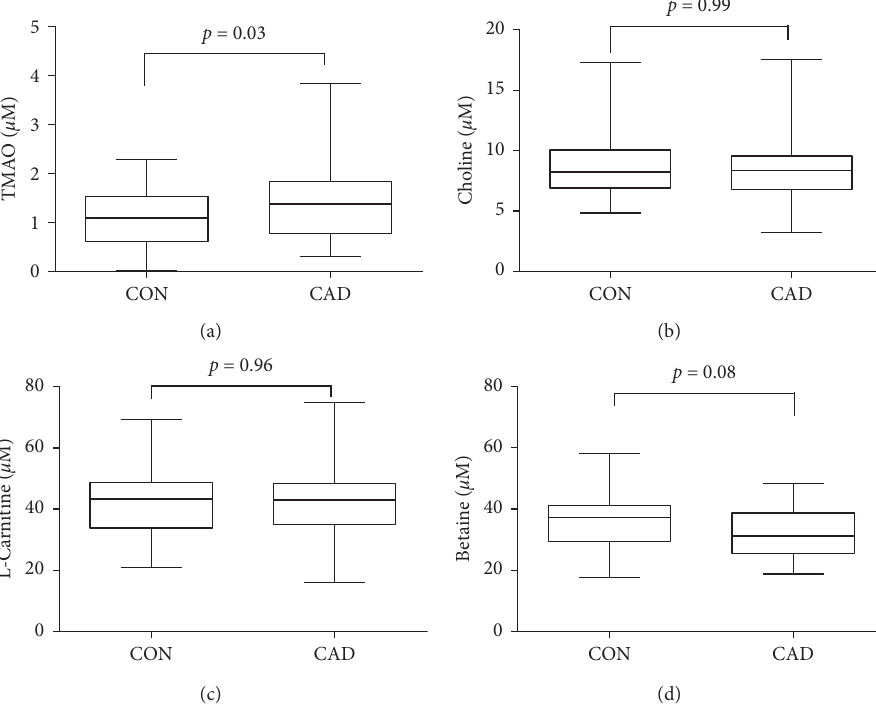
Figure 1: Comparison of plasma TMAO, choline, L-carnitine, and betaine levels between CAD and CON groups. Detected plasma TMAO (a), choline (b), L-carnitine (c), and betaine (d) concentration in CAD and CON